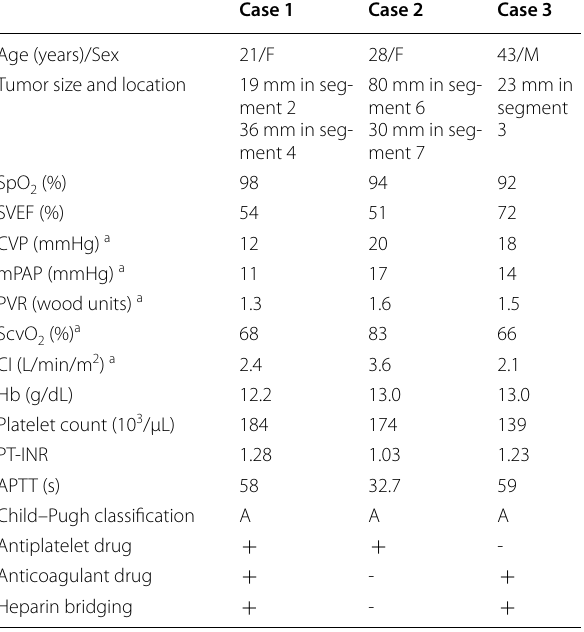
a Values from cardiac catheterization are within one month prior to surgery APTT Activated partial thromboplastin time, CI Cardiac index, CVP Central venous pressure, F Female, Hb Hemoglobin, INR International normalized ration of partial thrombin time, M male, mPAP mean pulmonary artery pressure, PVR pulmonary vascular resistance, SpO 2 oxygen saturation, ScvO 2 central venous blood oxygen saturation, SVEF systemic ventricular ejection